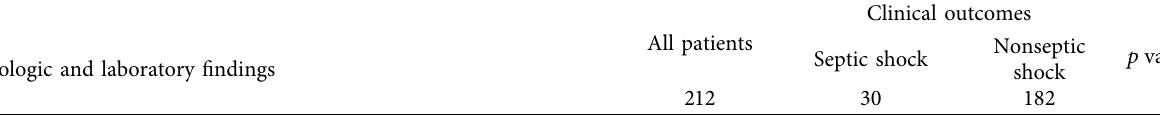
Table 2: Radiographic and laboratory findings of patients with